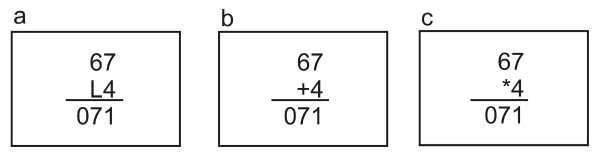
Task presentations for experiment 3. The task layout for reading (a), adding (b) and multiplying periods (c), for comparison.